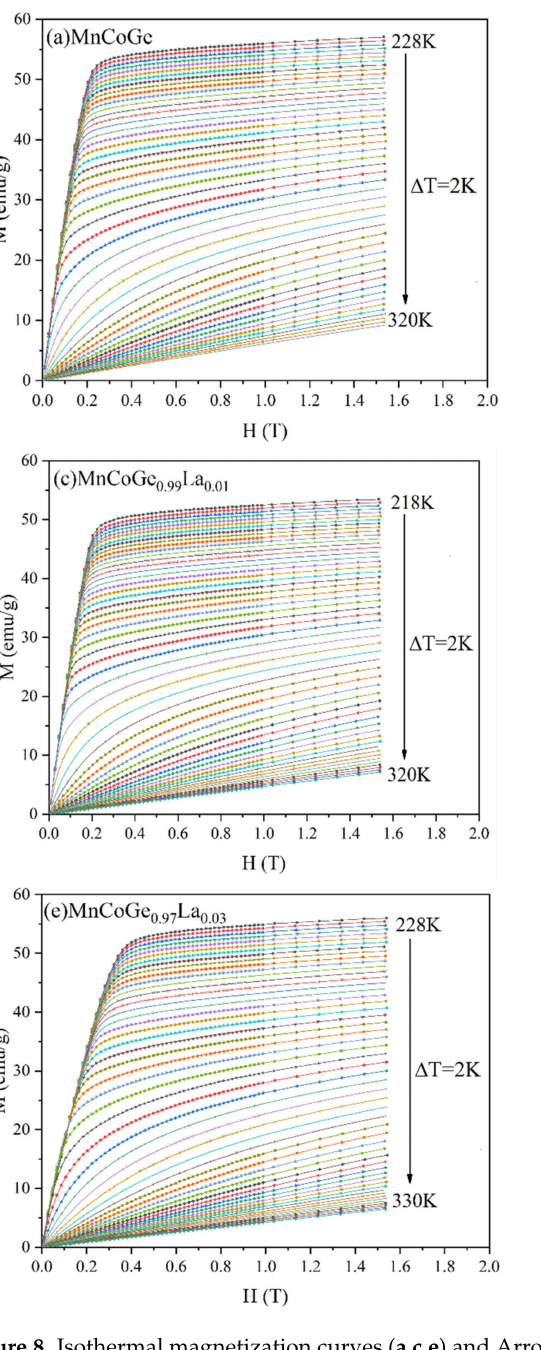
Figure 8. Isothermal magnetization curves ( a,c,e ) and Arrottt curves ( b,d,f ) of MnCoGe 1 − x La x at different